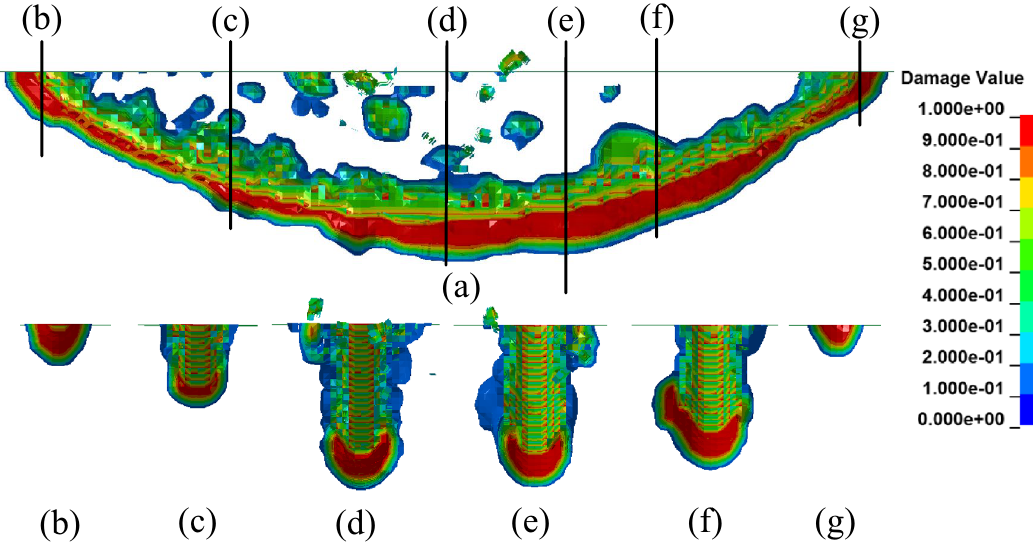
Figure 6. The distribution of different cross-sections in the y-direction.